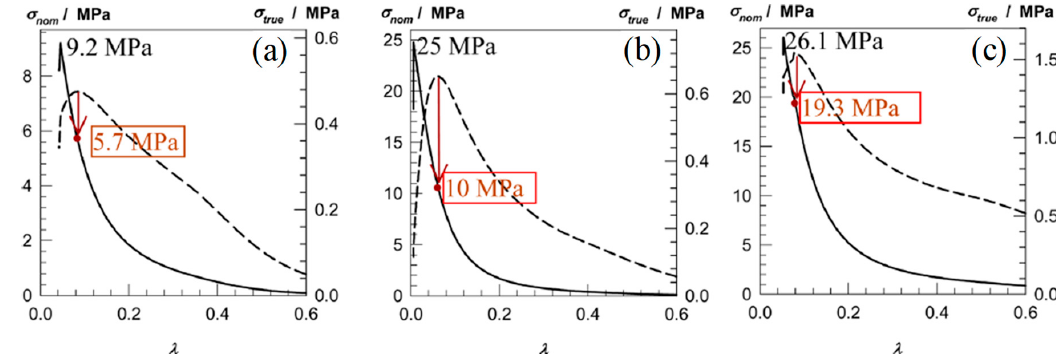
Figure 3. Typical compressive stress–strain curves for the hydrogels, plotting both the nominal (solid curves) and true (dashed curves) stress against the deformation ratio, λ . Red circles are taken as the points of failure in the gel samples. ( a ) PAAm / PAAm double-network (DN) hydrogel formed at 4 mol% PEGDMA. n 21 = 3.6. ( b ) PAAm / PAAm / PAAm triple-network (TN) hydrogel formed at 4 mol% PEGDMA. n 21 = 2.6, n 32 / 1 = 17. ( c ) PDMAAm / PDMAAm / PDMAAm TN hydrogel prepared using 10 mol% PEGDMA. n 21 = 4.0, n 32 / 1 = 33. PAAm: polyacrylamide; PDMAAm: poly( N , N -dimethylacrylamide). Adapted and reprinted with permission from [16]. Copyright 2014 American Chemical Society.